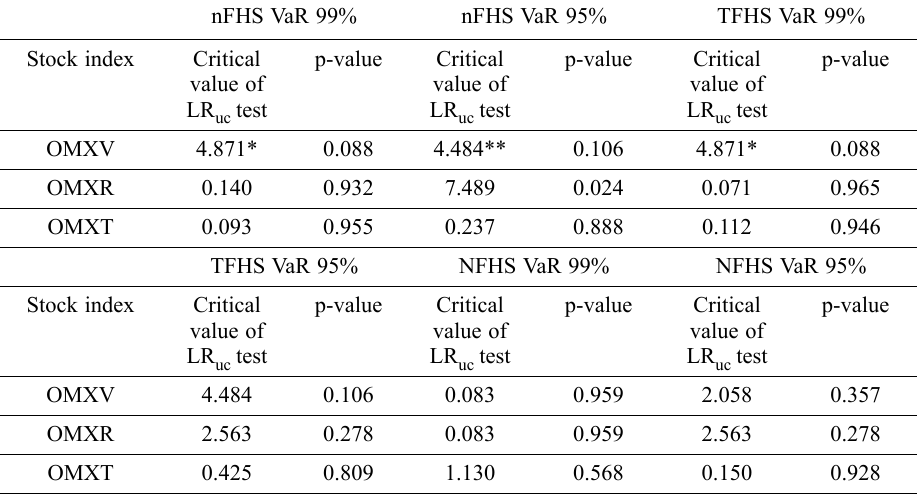
Table 4. Christoffersen’s conditional coverage test backtesting